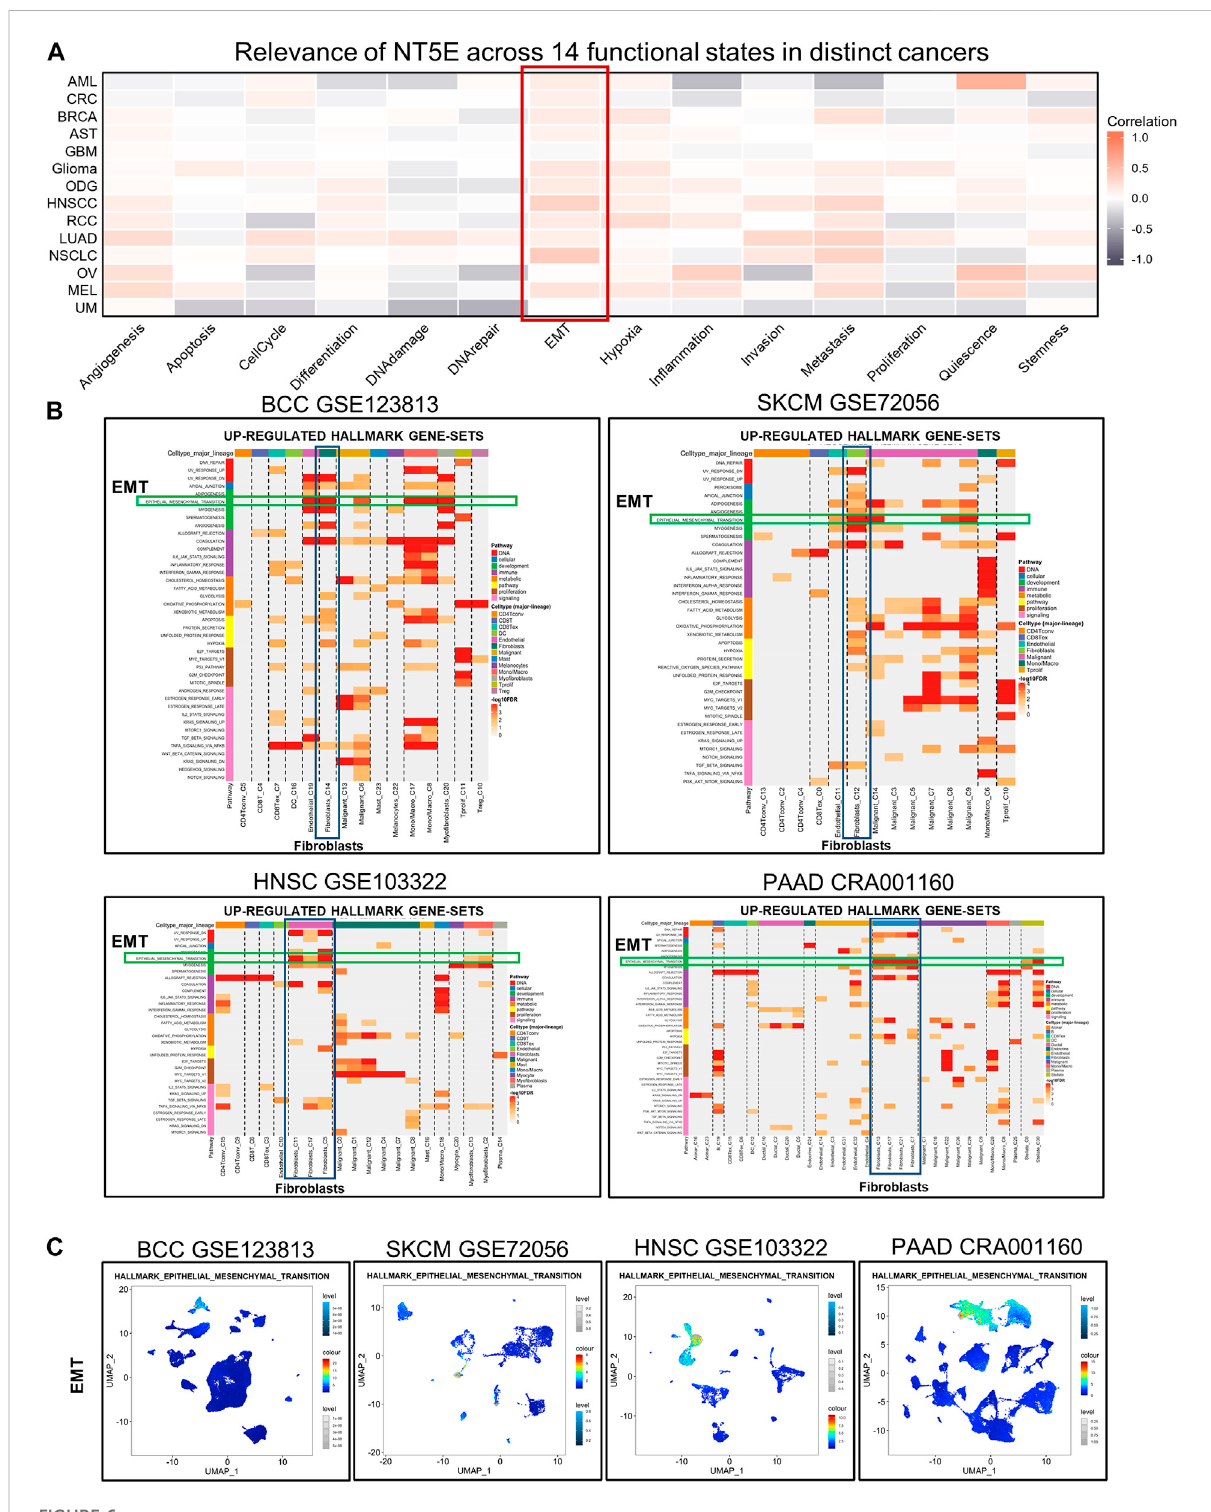
FIGURE 6 (A) RelevanceofNT5Eacross14functionalstatesindistinctcancersbasedonCancerSEAdatabase. (B) TheUP-REGULATEDHALLMARKGENE- SETS enrichment analysis of NT5E in pan-cancer. (C) EMT in multiple cell subsets were obtained using the single-cell Signature Explorer function in the GSEA module of TISCH